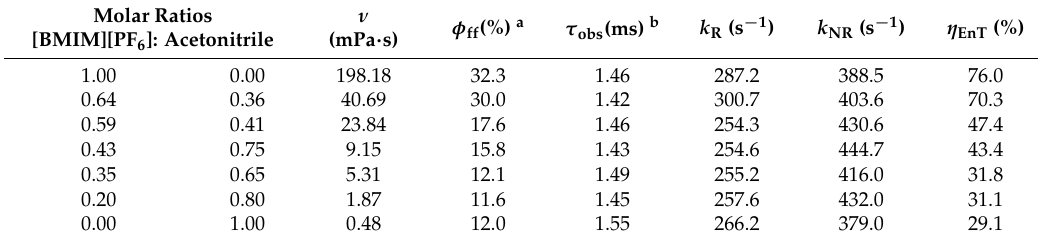
Table 3. φ ff , τ obs , n , k R , k NR , and η EnT values for EuL in mixed solvents of [BMIM][PF 6 ] and acetonitrile along with the kinetic viscosity values ( ν ) [27] ( a : λ ex = 328 nm, λ mon = 550–780 nm, b : λ ex = 340 nm, λ mon = 616 nm).